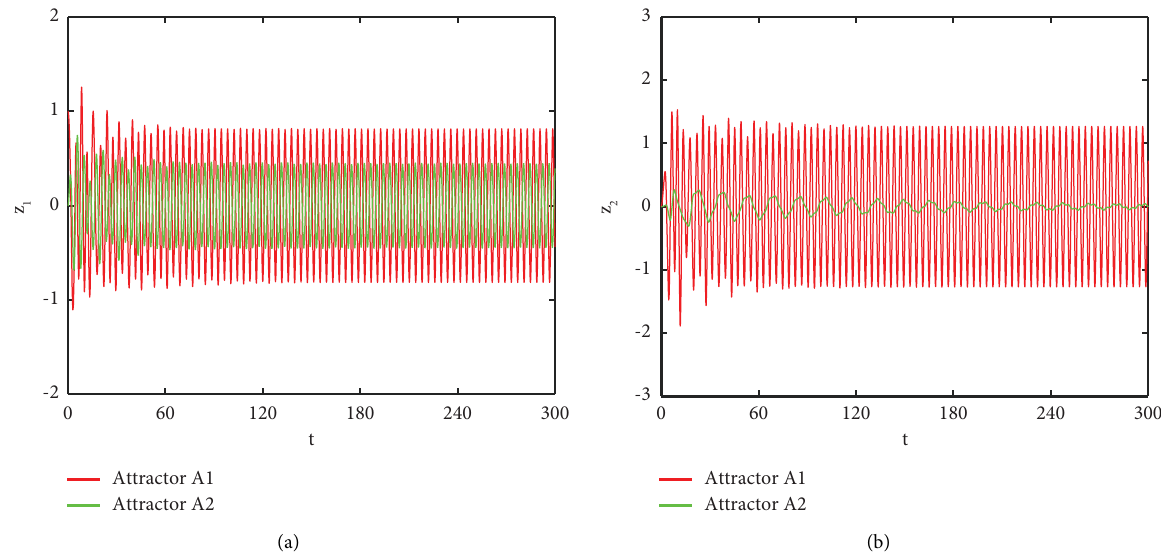
Figure 7: Te time history of the system responses under diferent initial conditions. (a) Te mechanical equipment vibration response. (b) Te NES vibration response.